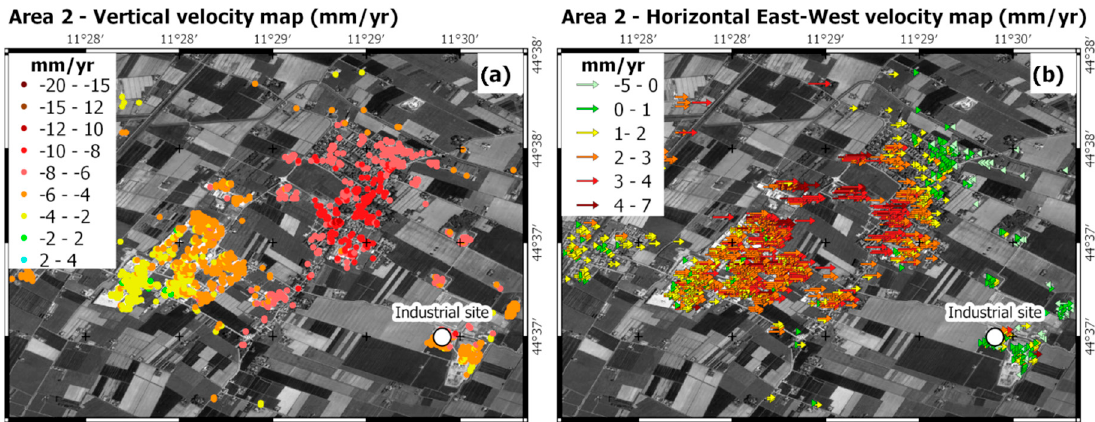
Figure 7. Vertical and horizontal velocity maps (mm/yr) within area 2. Negative vertical rates in ( a ) indicate subsiding phenomena; in ( b ) negative rates indicate West-oriented horizontal displacement, positive rates indicate East-oriented horizontal displacement. Module of horizontal displacements are better described using row instead of points. The white dot denotes the main site of industrial activity.